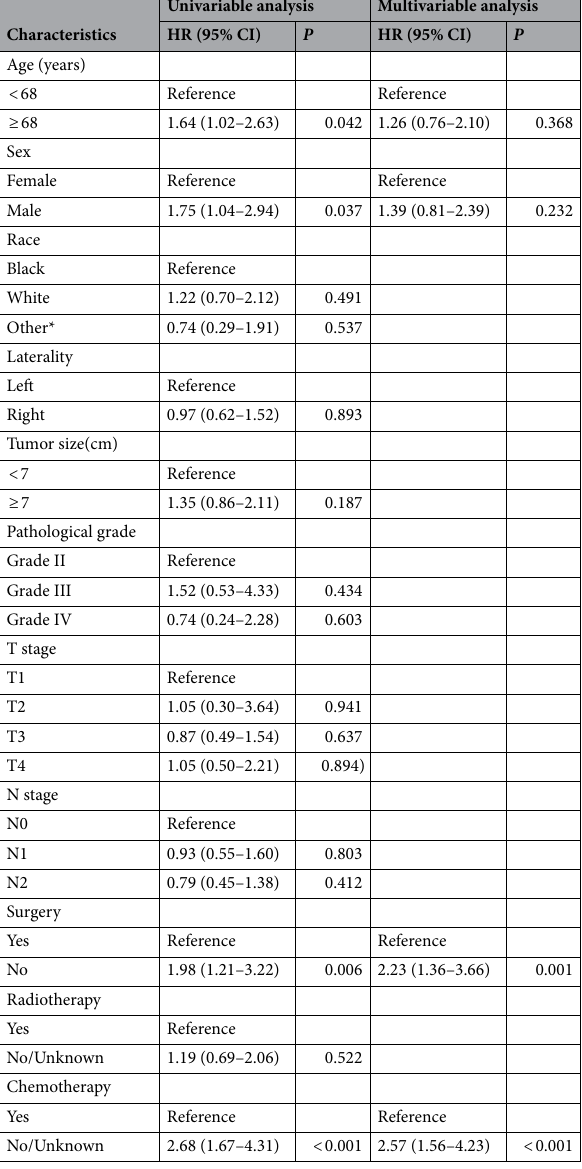
Table 3. Univariate and Multivariate Cox Regression Analysis of the Associations between Clinicopathological Features and CSS in Patients with Metastatic CDCs. CDC, renal collecting duct carcinoma; CI, confidence interval; HR, hazard ratio; CSS, cancer-specific survival. *Other included American Indian/ Alaskan Native and Asian/Pacific